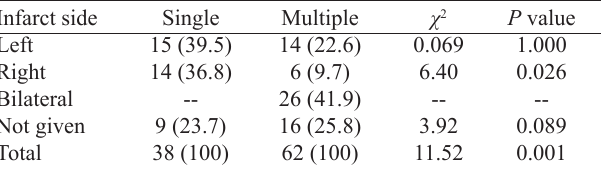
Table 7. Comparisons of site and number of cerebral infarcts.